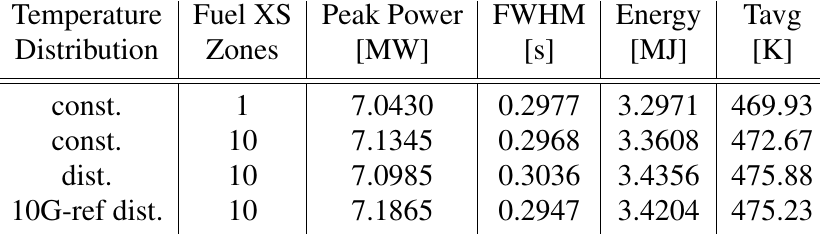
Table 5: 1-D homogeneous results with 10 neutron energy